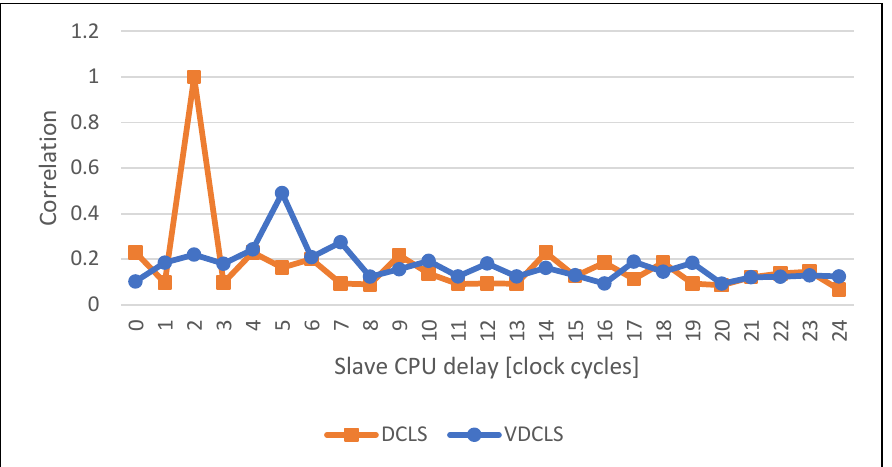
Figure 14. Comparison of the execution correlation between master and slave CPUs using VDCLS and legacy DCLS technique while executing the EDCSA key compression algorithm.